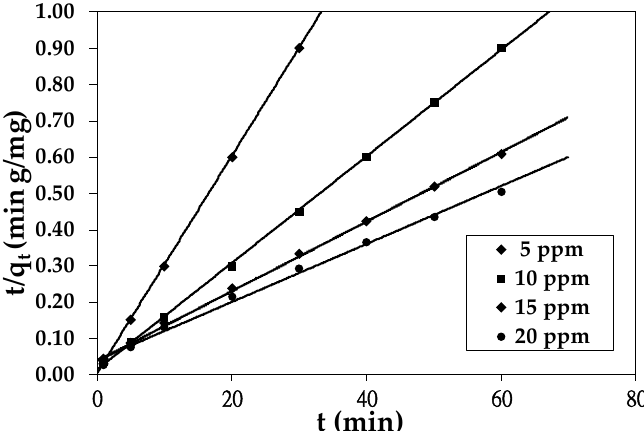
Figure 5. Variations of dimensionless concentration (C t /C 0 ) vs. time under various WCH-AC dos- ages (initial MB concentration = 10 mg/L, initial pH = 7.0); symbols: experimental data, full lines: obtained from the pseudo-second-order model parameters (Table 2).